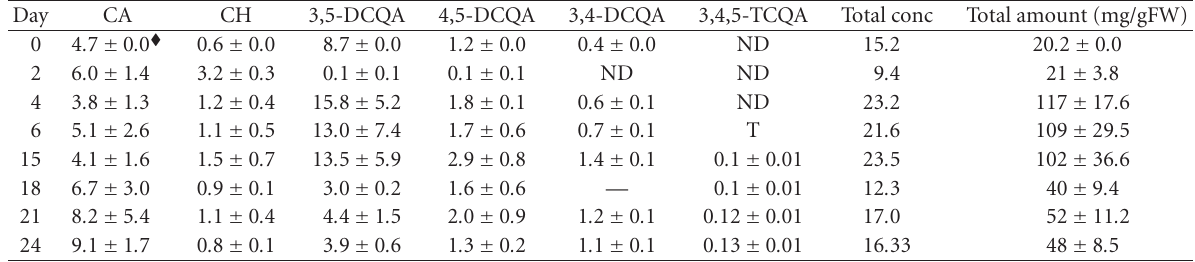
Table 1. Relative concentrations ∗ (%) of selected phenolic compounds in the extract of the PL cell line tissue grown on a high- anthocyanin producing medium during 24 days. (T: concentration less than 0.1%; ND: not detected.)